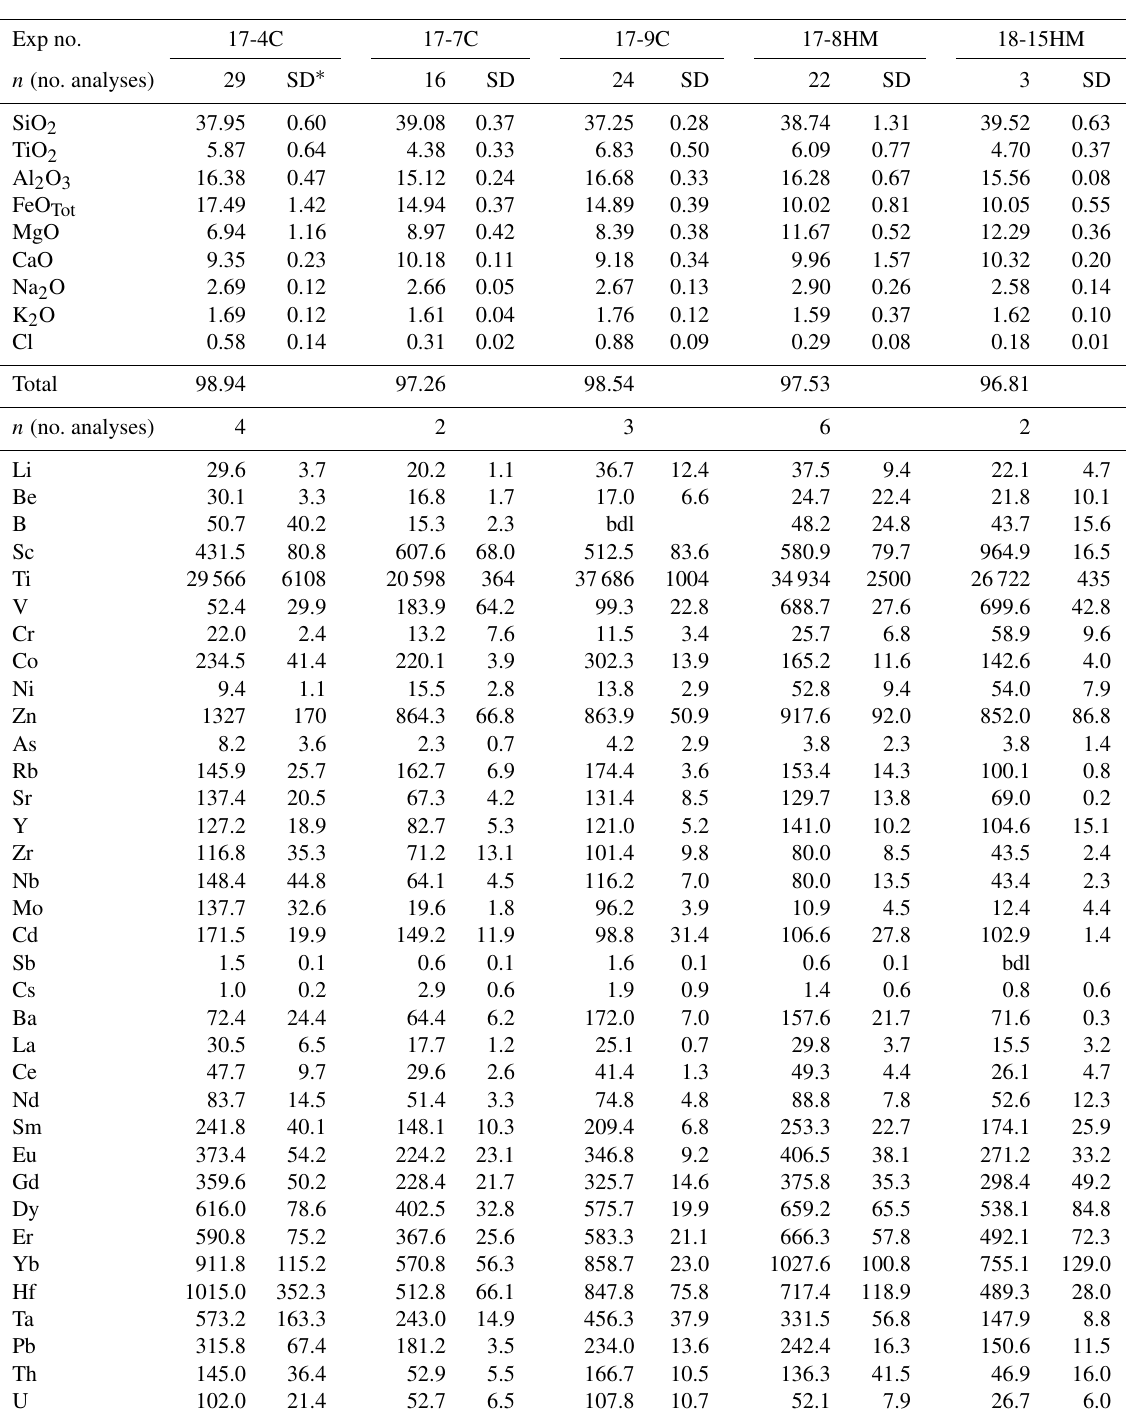
Table 4. Amphibole compositions (major elements inwt% and trace elements in µg / g). Exp